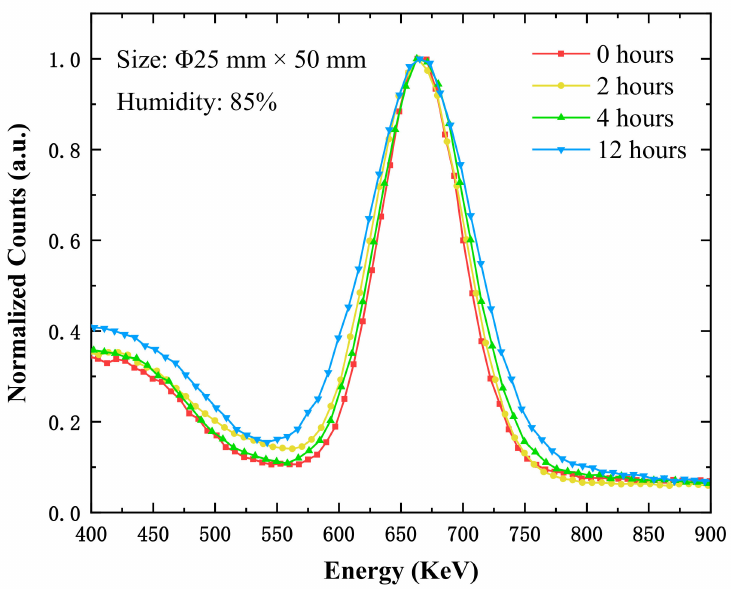
Figure 5. The energy spectra of the CsI(Na) crystal (size: Φ 25 mm × 50 mm) with different exposure times at 85% relative humidity under 137 Cs-662 keV γ ray excitation.